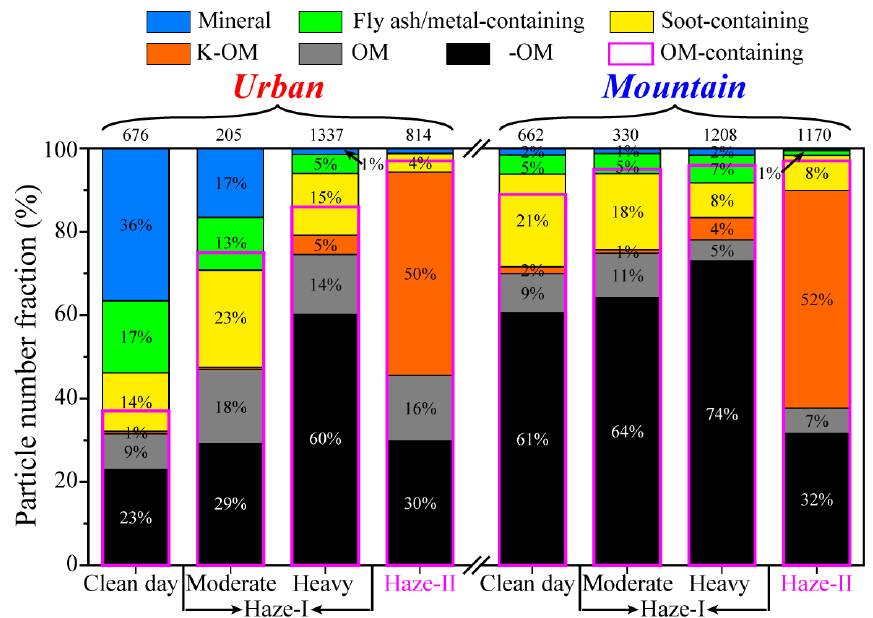
Figure 4. Variation in number fractions of different types of particles at the urban and mountain sites. Analyzed particle numbers are listed at the top of each bar.